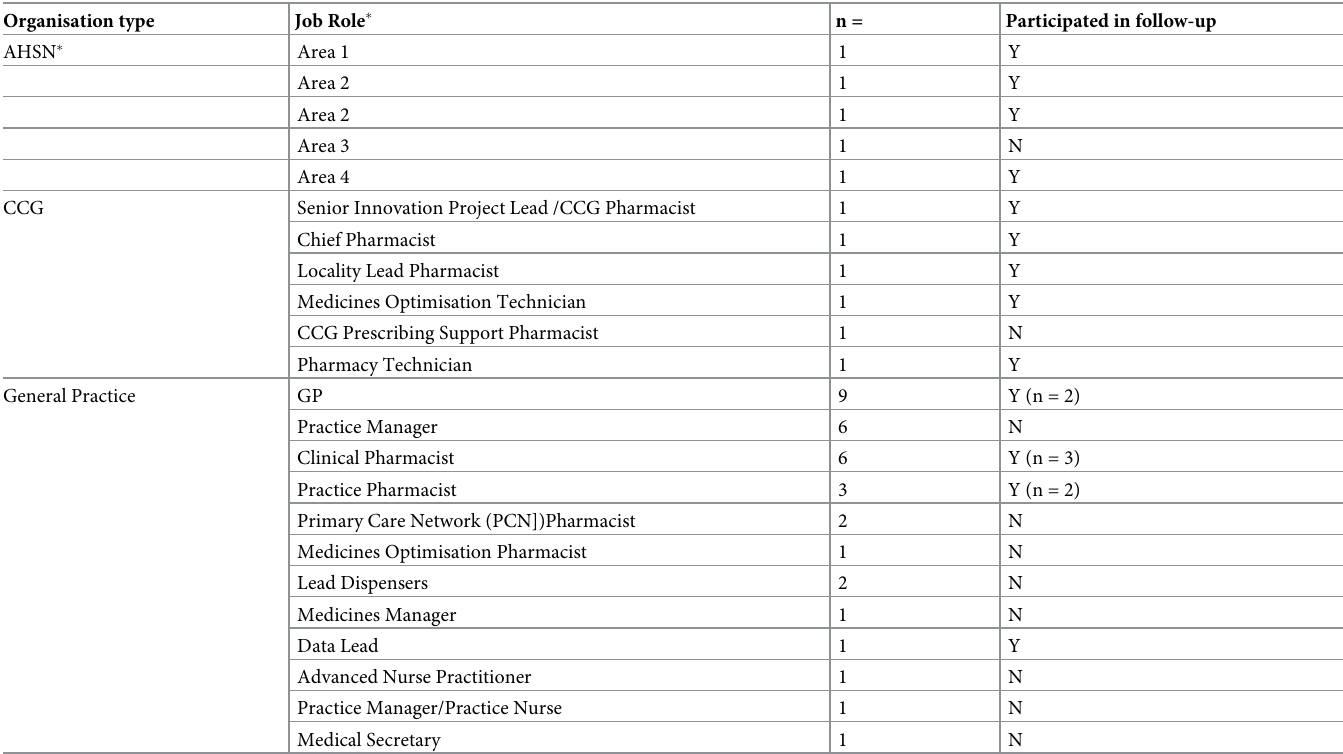
Table 3. Interviewee